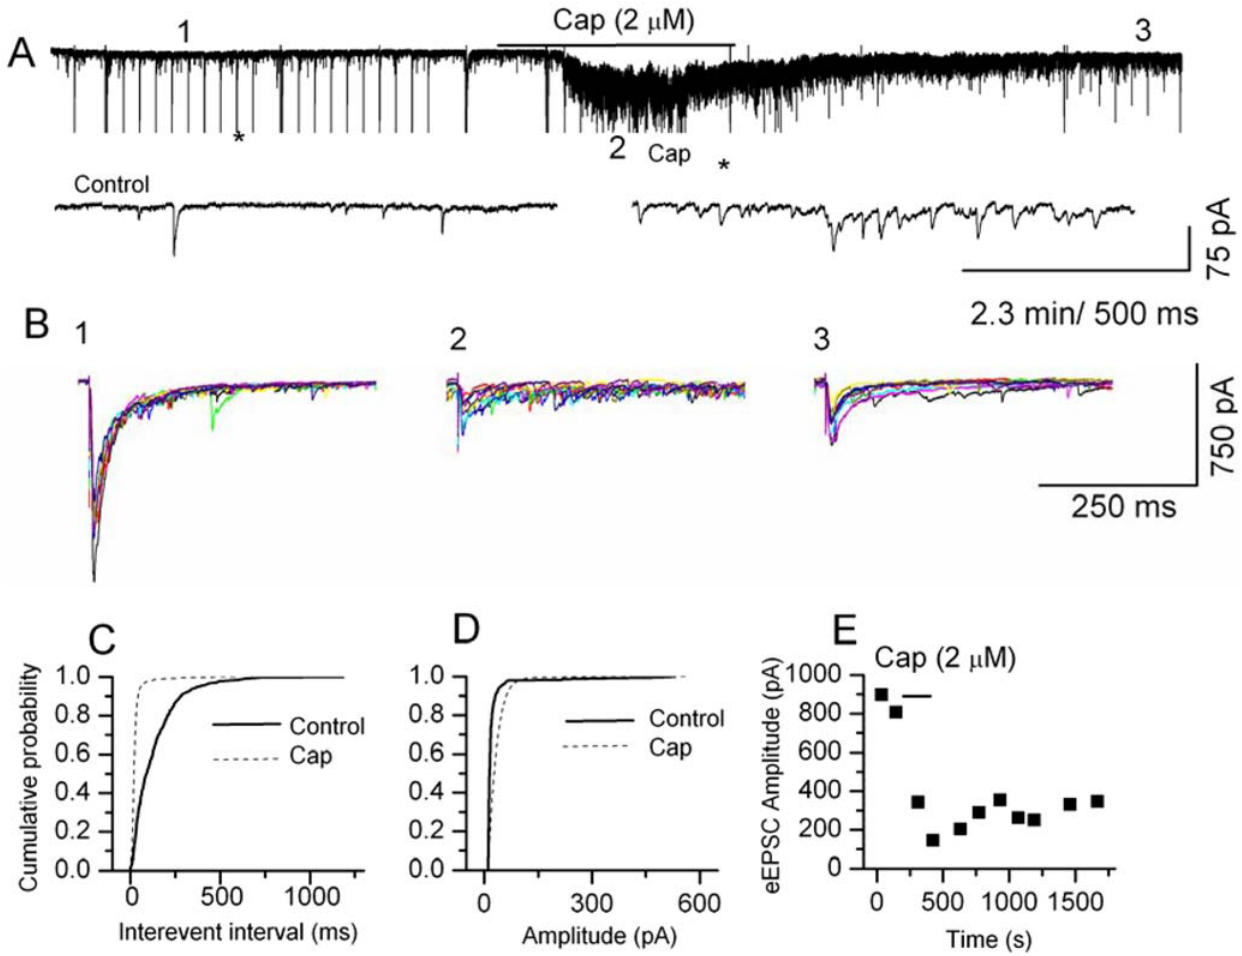
Figure 1. Modulation of synaptic transmission by capsaicin at the first sensory synapse in spinal cord. A. Application of capsaicin (2 m M) increased the frequency of sEPSCs in a reversible manner. The evoked responses are truncated. The synaptic events are shown at a higher time resolution below (the regions denoted by asterisks). B. Superimposed traces (10) of evoked synaptic responses recorded at three different time points from the same neurons. In the presence of capsaicin eEPSCs either failed or exhibited a reduction in amplitude. C. Cumulative probability plot showing decreased inter-event intervals representing increased frequency of sEPSCs ( p , 0.0001, KS test). D. The increase in frequency was not accompanied by a significant change in amplitude. E. The reduction or failure of eEPSC amplitude partially reversed following washout.